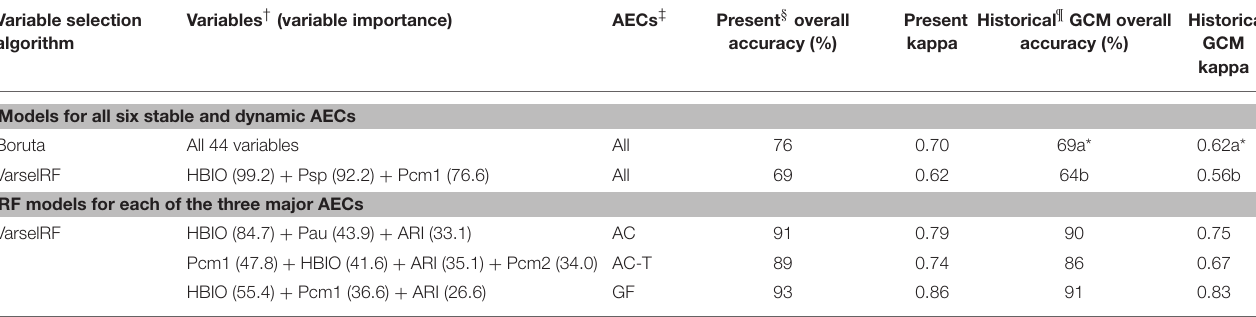
TABLE 2 | Bioclimatic variables selected by Random Forest (RF) modeling of six and three agro-ecological classes (AECs). Variable selection algorithm